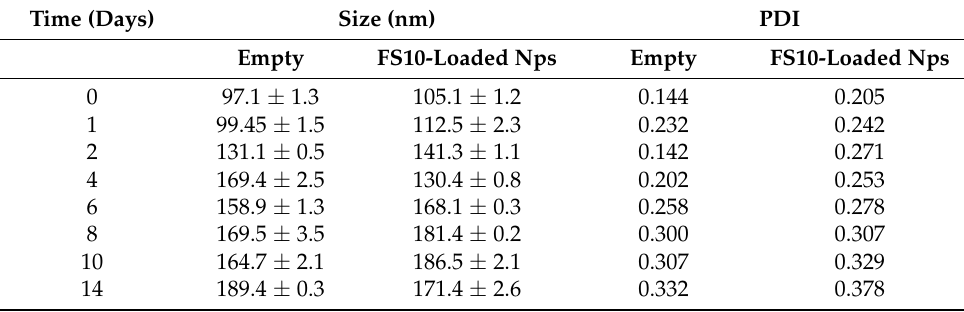
Table 2. Stability of empty and FS10-loaded PEG-PLGA Nps at 4 ◦ C up to 14